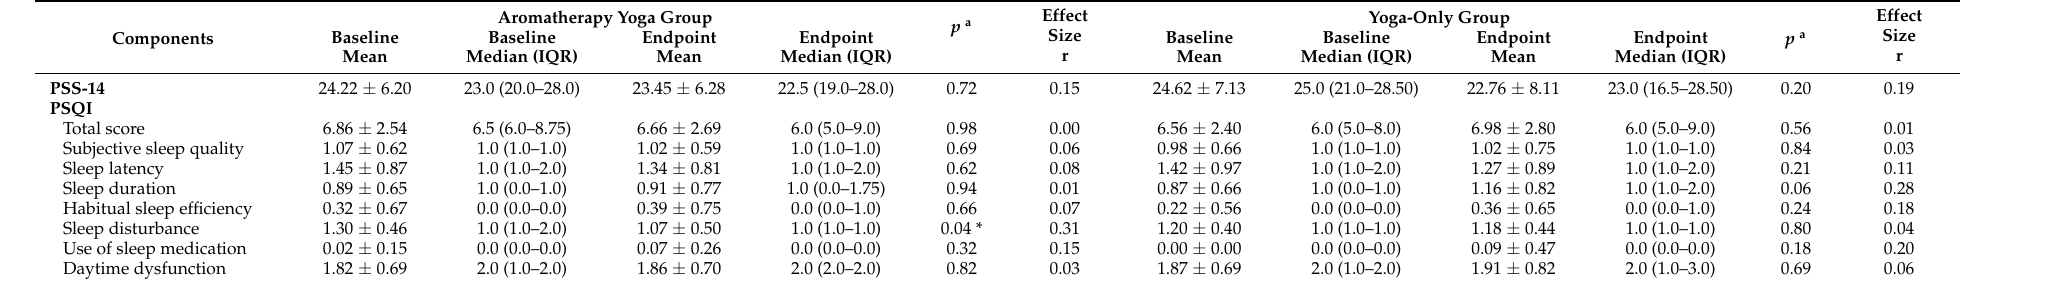
Table 2. Intragroup differences in the PSS-14 and PSQI scores in the aromatherapy yoga group and the yoga-only group.